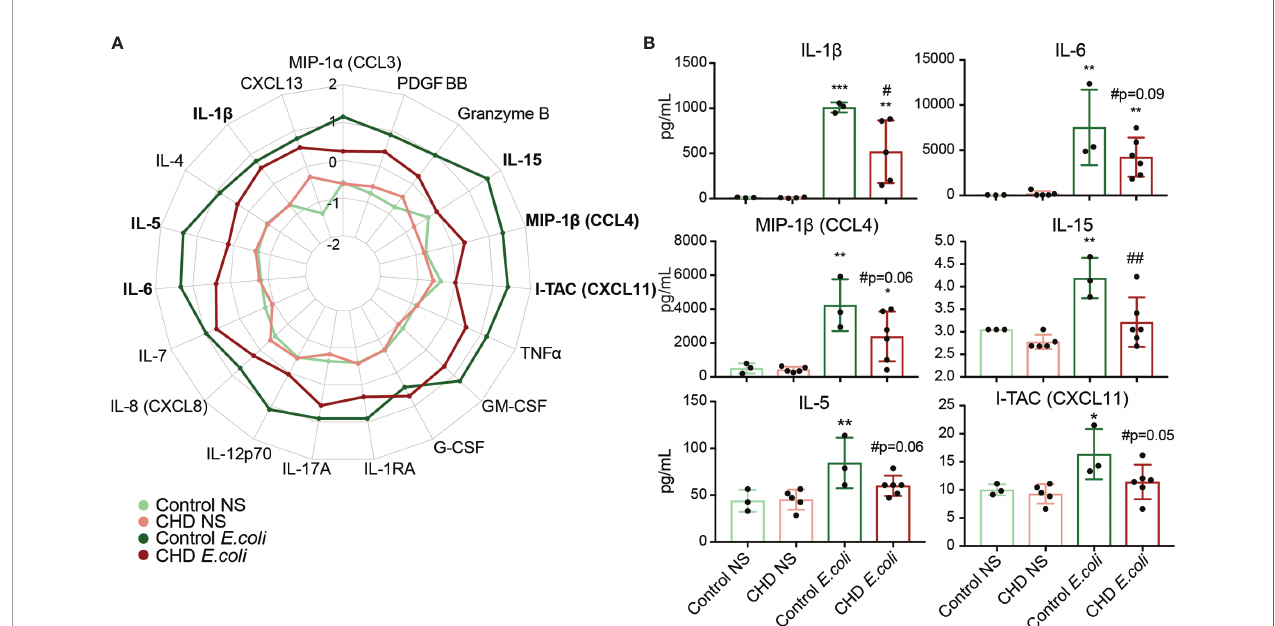
FIGURE 5 | Monocyte response to E. coli is dampened with CHD. Puri fi ed monocytes (n = 2 Control Male, 1 Control Female/2 CHD Male, 4 CHD Female) were stimulated with heat-killed E. coli bacteria for 16 hours. (A) Spider plot representing average Z-scores for each group across the indicated analytes measured by Luminex. (B) Bar plots showing concentration (pg/ml) of selected immune mediators (TNF a , IL-6, MIP-1b, IL-15, IL-5, I-TAC). *p < 0.05, **p < 0.01, ***p < 0.001 between E. coli and unstimulated condition. If indicated, # is signi fi cance between CHD and control for each stimulation